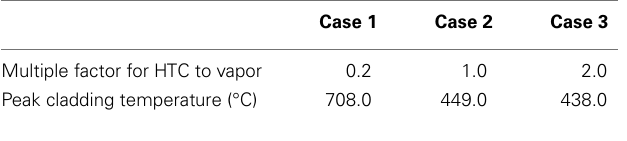
Table 5 | Sensitivity analysis on HTC to vapor .